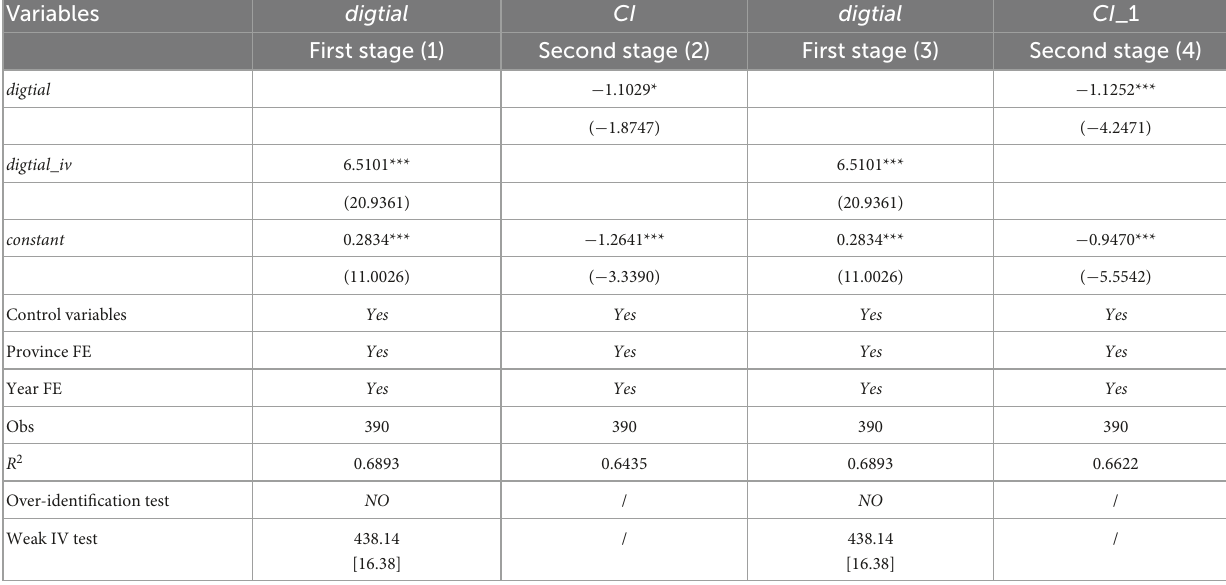
TABLE 6 Endogenous test results a .